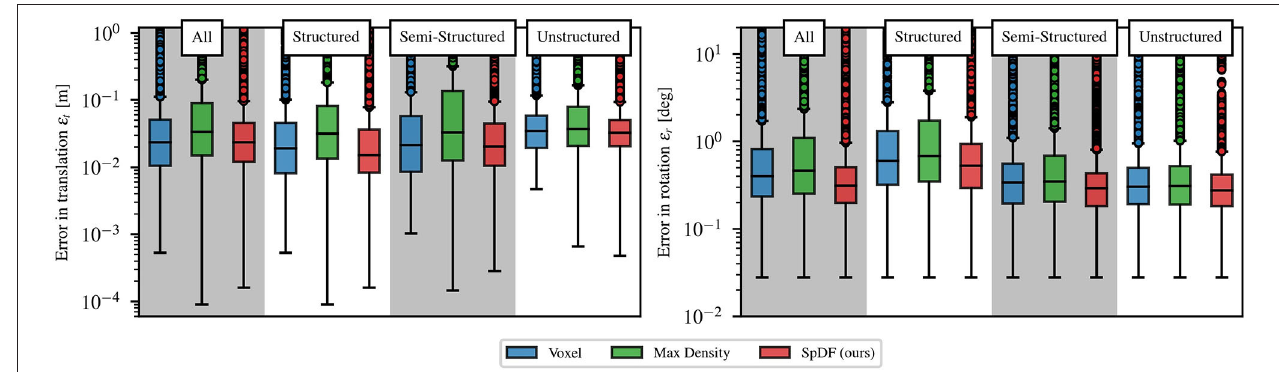
FIGURE 8 | Statistic analysis of the translation and rotation errors at high compression ratio between 85 and 99.9 % for each environment (structured, semi-structured, unstructured and all environments concatenated), for the top three methods, graphically represented as box plots. Medians are given with their first Q 1 and third Q 3 quartiles. The spacing between the different parts of the box indicate the degree of dispersion (spread) and skewness in the errors. Boxes are given Q 3 Q 1 is the inter-quartile range. All environments present similar errors, except in rotation for the structured with whiskers with maximum 1.5 IQR, where IQR = − environment which presents a slightly higher error. The spreads and medians are of the same order for the three methods.